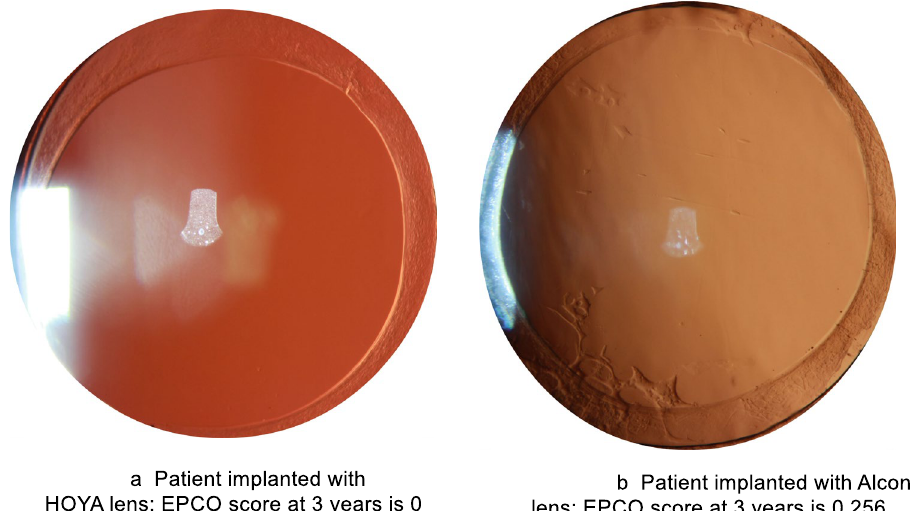
Figure 1. Patient implanted with a Vivinex lens; EPCO score at 3 years is 0 ( a ) and a patient implanted with Acrysof lens; EPCO score at 3 years is 0.256 ( b